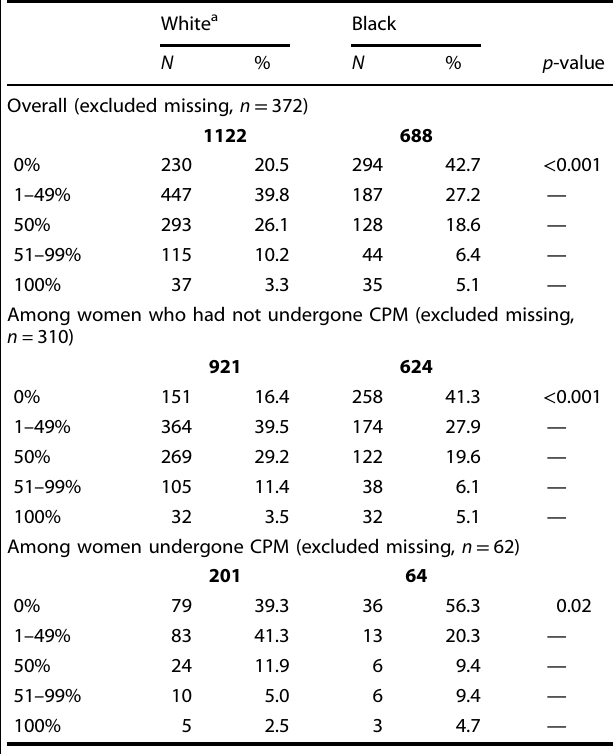
Table 3. Comparison of patient risk perception of a second breast cancer by race ( N = 1810)